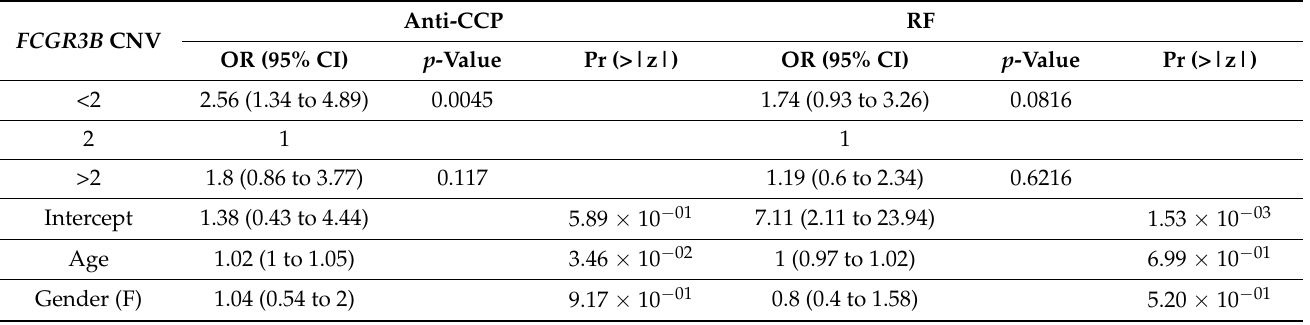
Table 2. Association results of FCGR3B CNV with anti-CCP and RF seropositivity in RA